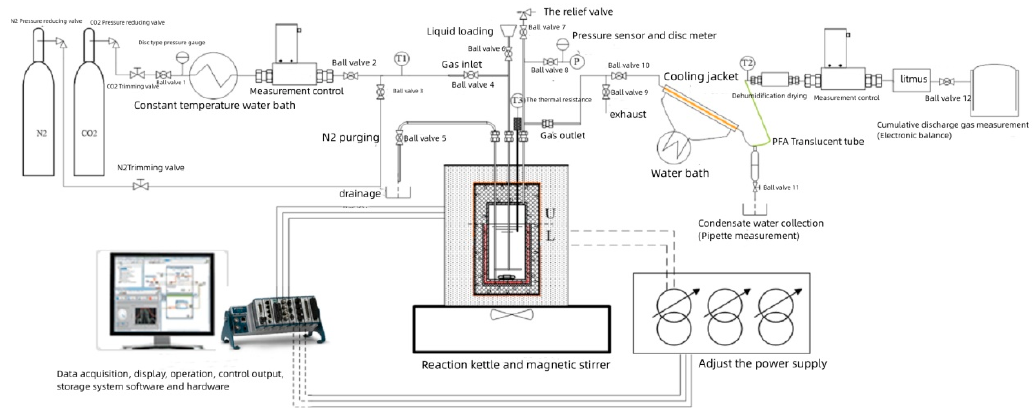
Figure 1. Composition of reaction heat test device.